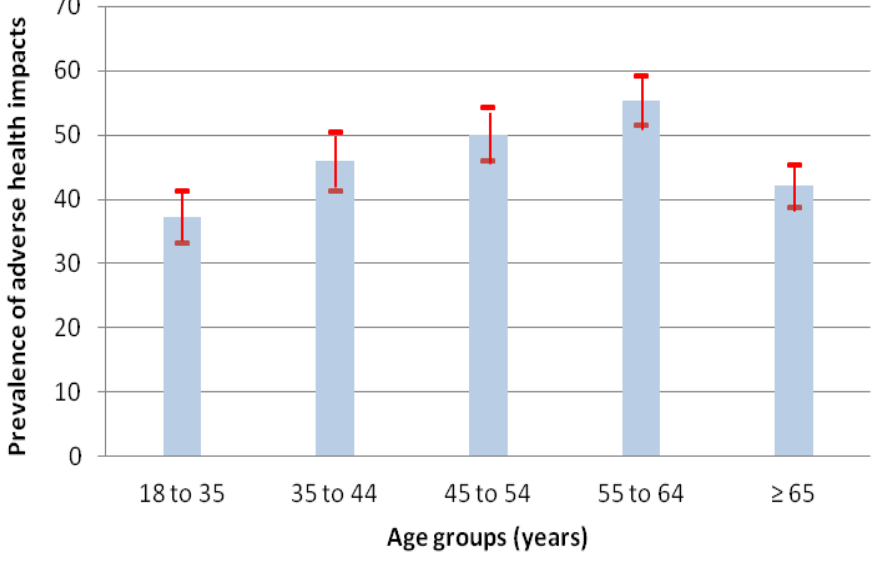
Figure 2. Prevalence of perceived adverse health effects during very hot and humid summer conditions, (with 95% confidence intervals), by age group.